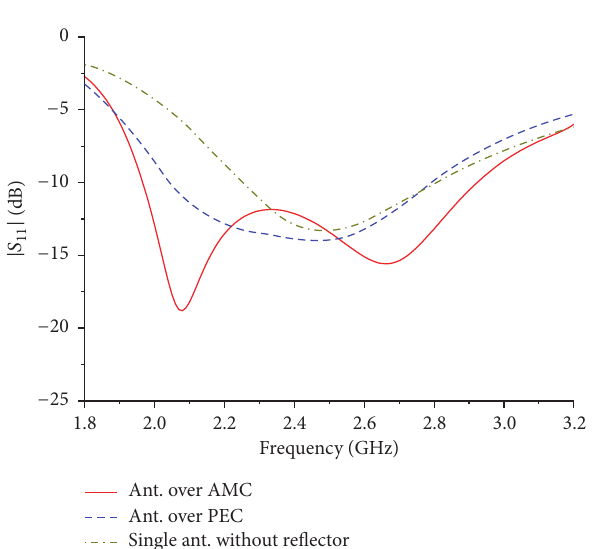
Figure 5: Simulated |𝑆 11 | of the proposed dual-polarized antenna with different 𝑊 1 .